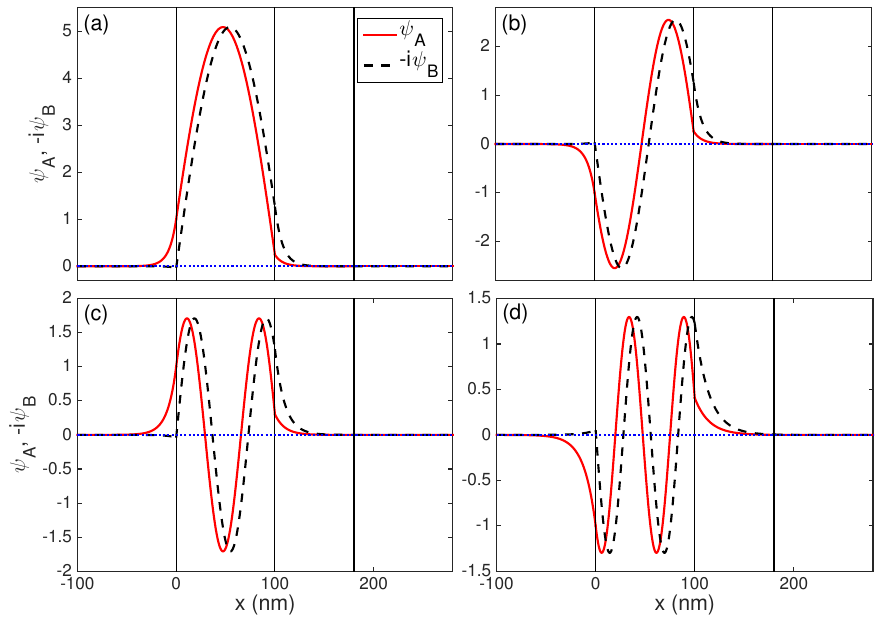
Figure 5. The wave function Ψ A (solid) and − i Ψ B (dashed) of guided modes as a function of distance corresponding to the intersections in Figure 3b: ( a ) k 2 x h 1 = 2.8959, θ = 78.2908 o ; ( b ) k 2 x h 1 = 5.7775, θ = 66.1160 o ; ( c ) k 2 x h 1 = 8.6220, θ = 52.8267 o ; and ( d ) k 2 x h 1 = 11.3661, θ = 37.1996 o